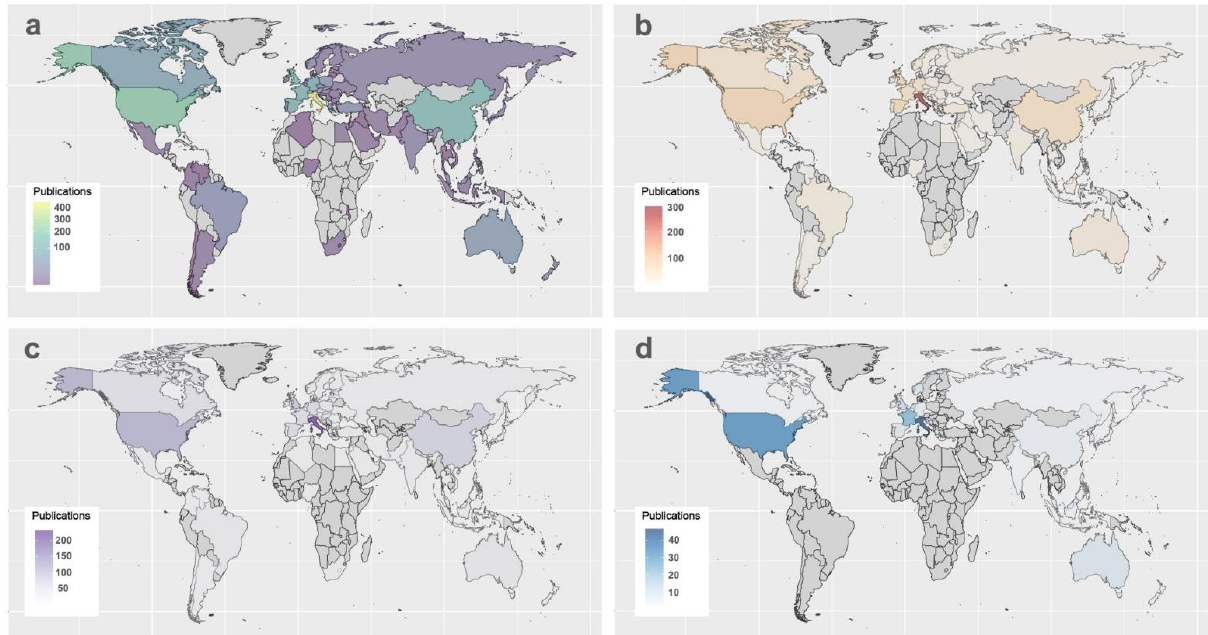
Figure 3. Geographical distribution of the countries who funded the study in the analysed publica- tions: ( a ) total number of publications, ( b ) ground-based applications, ( c ) airborne-photogrammetry applications, and ( d ) underwater applications.